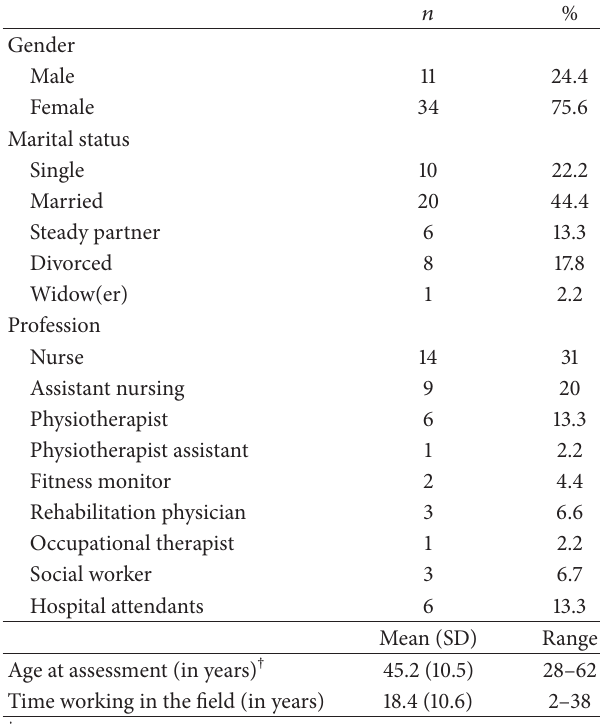
Table 1: Demographic and job-related characteristics of the sample ( 𝑁 = 45